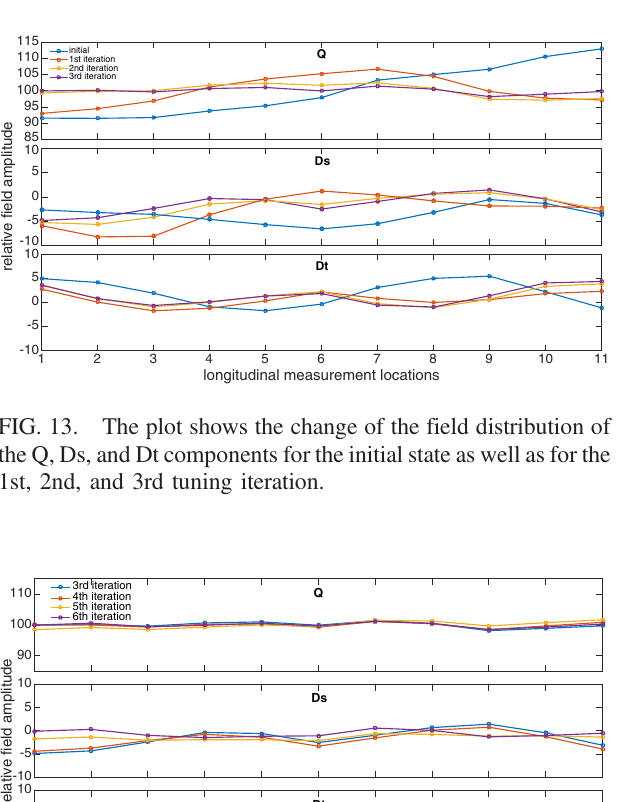
FIG. 15. The plot shows several so called predictions of how good a certain tuner setting solution compensates the longitudinal field errors from top to bottom for the Q, Ds, and Dt component. The yellow curve shows that a matrix change after 4th iteration is compensating both dipole components much better than without a matrix